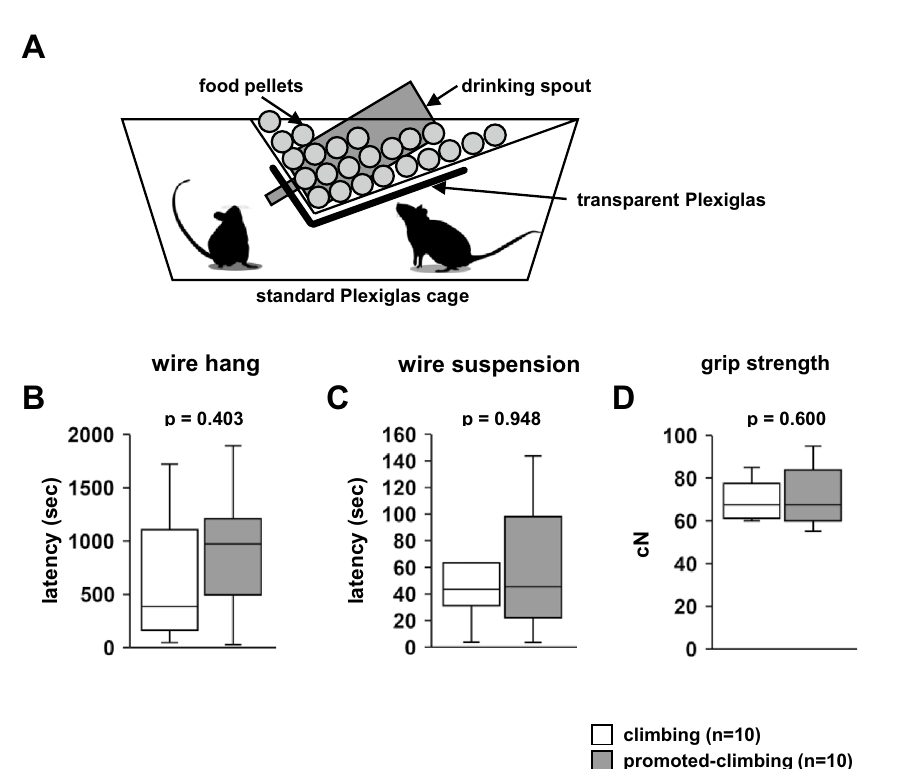
Figure 10. The effect of promoted-climbing on physical characteristics in adulthood. ( A ) A schematic diagram of the promoted-climbing condition cage. The latency to fall in the wire hang test ( B ) and wire suspension test ( C ), and grip strength test ( D ). Data are presented as box plots ( B – D ). *Statistical significance is represented by asterisks: * p < 0.05, + p < 0.1. P -values were calculated using the one-way analysis of variance ( B – D ). ( B – D ) climbing: n = 10; non-climbing: n =